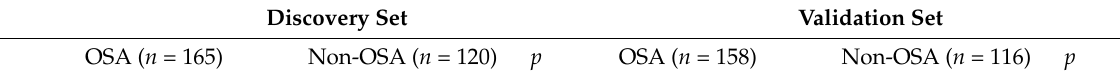
Table 1. Demographic and clinical characteristics of hypertensive